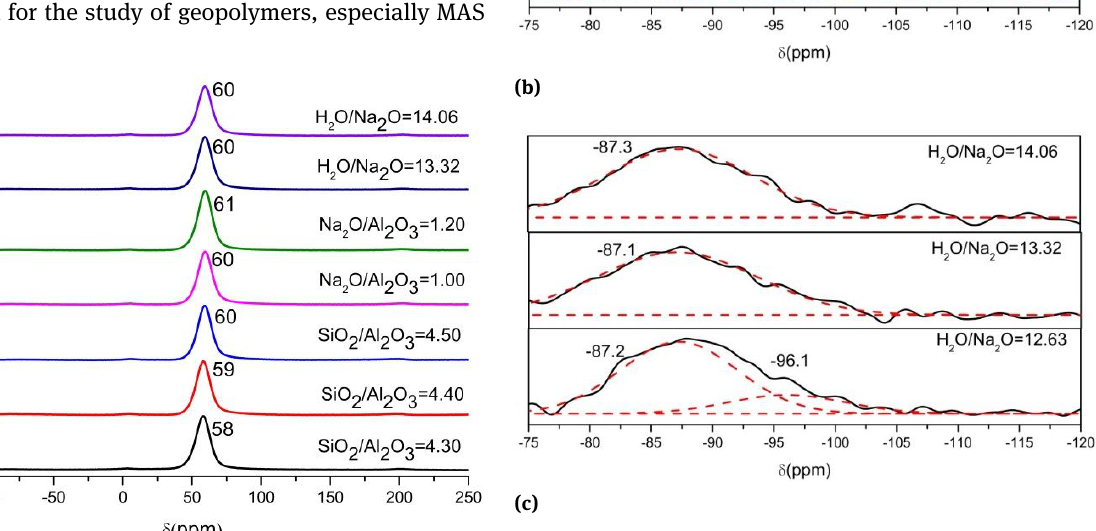
Figure 4: 29 Si MAS NMR spectrum of geopolymer with different molar